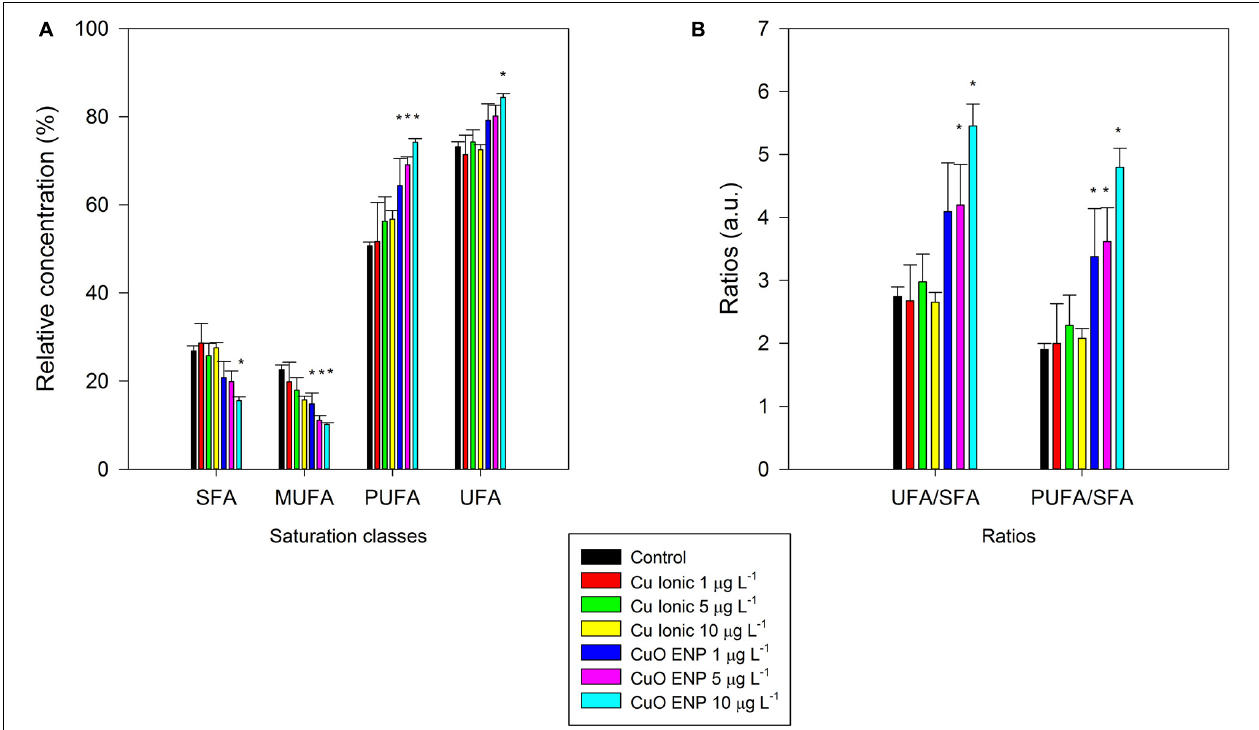
FIGURE 8 | Relative concentrations of fatty acid saturation classes ( A ; SFA, Saturated Fatty Acids; MUFA, Monounsaturated Fatty Acids; PUFA, Polyunsaturated Fatty Acids; and UFA, Unsaturated Fatty Acids) and ratios (B) , in P. tricornutum , after 3 days of exposure to increasing ionic Cu (black bars) and CuO ENP (gray bars) concentrations (average ± standard deviation, N = 3, *indicate significant differences compared with the control at p < 0.05).